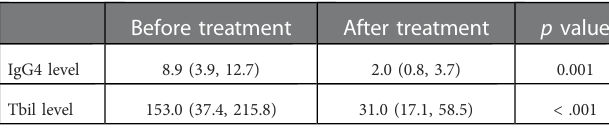
TABLE 5 Serological values in AIP before and after